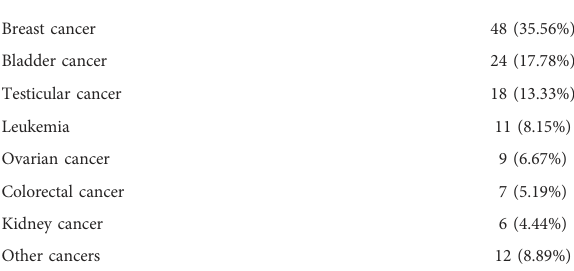
TABLE 3 Types of cancer. TABLE 4 Management plan and treatment